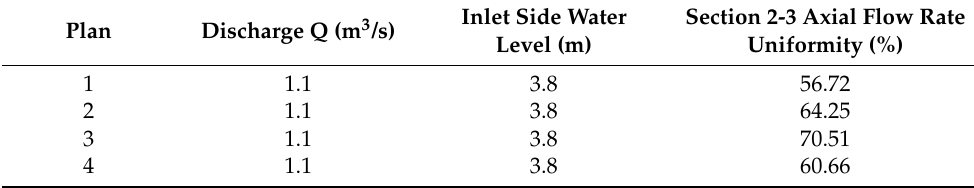
Table 4. CFD performance of the research program.